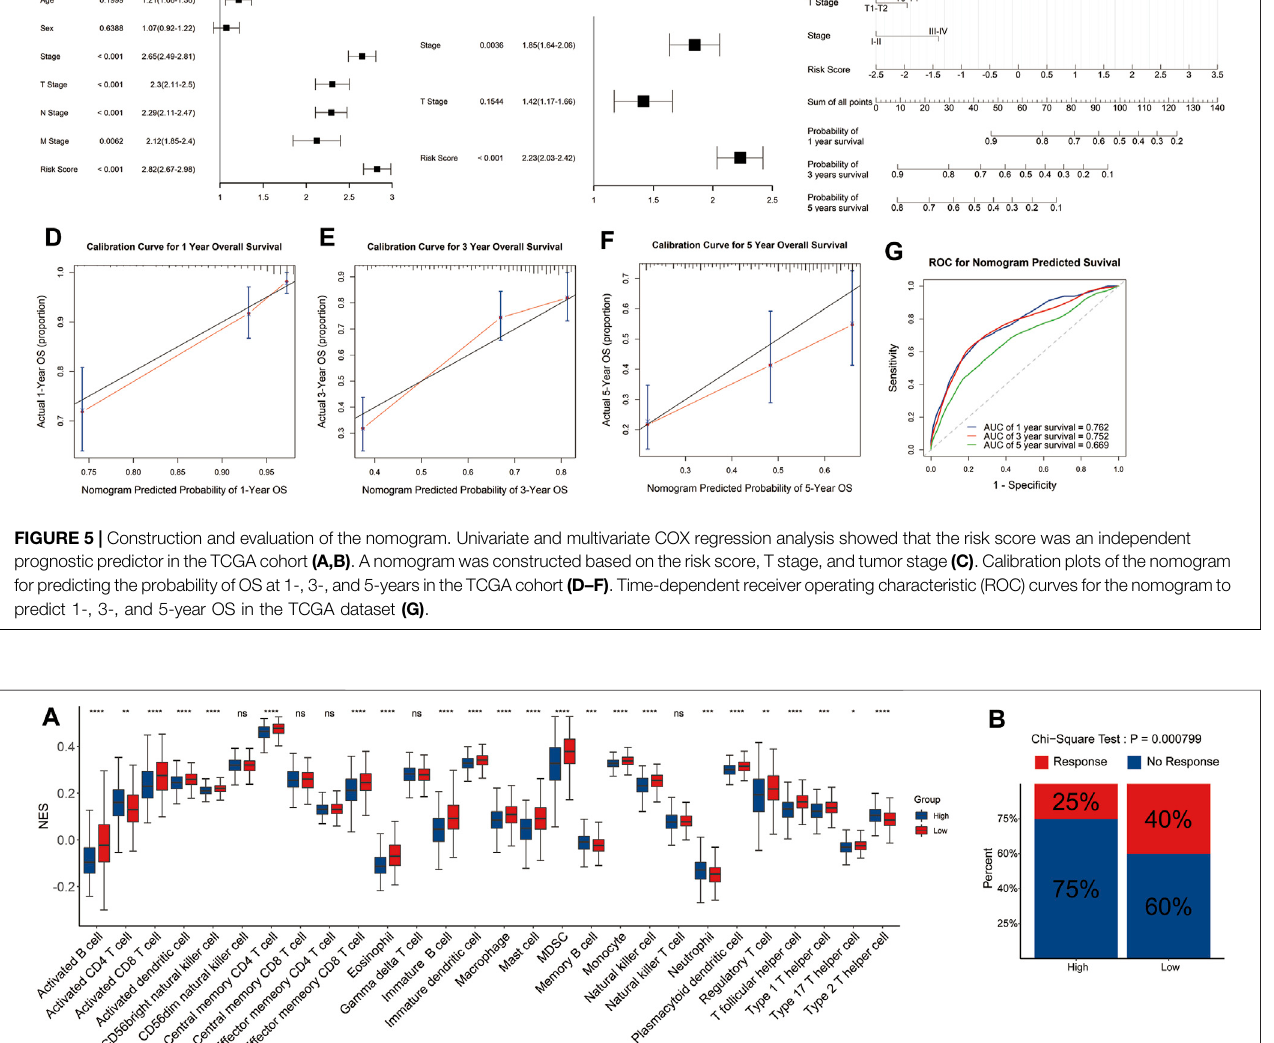
Frontiers in Genetics |